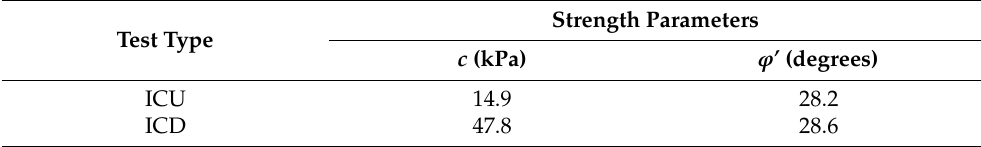
Table 4. Strength parameters of the isotropically consolidated